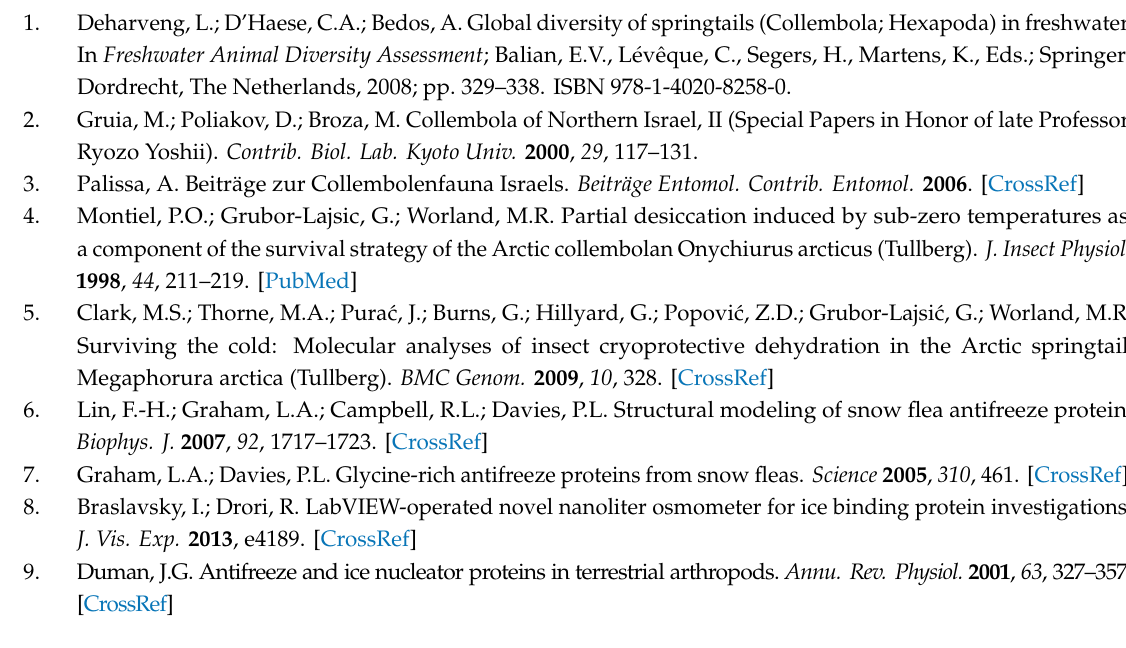
Figure S6: Circular dichroism spectroscopy data for the > 100 kDa protein fraction, Figure S7: Thermal hysteresis activity as a function of the concentration of the > 100kDa protein, Figure S8: Ice nucleation of the > 100 kDa protein